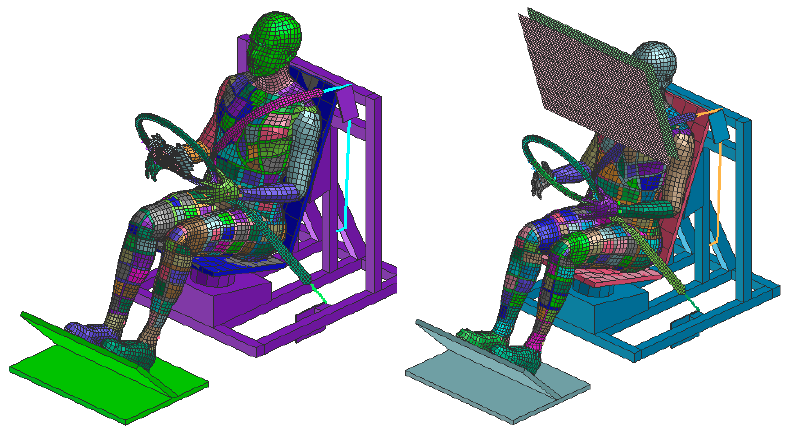
Figure 3. The sled test initial configurations. The airbag ( left ) and the nanobag ( right ).